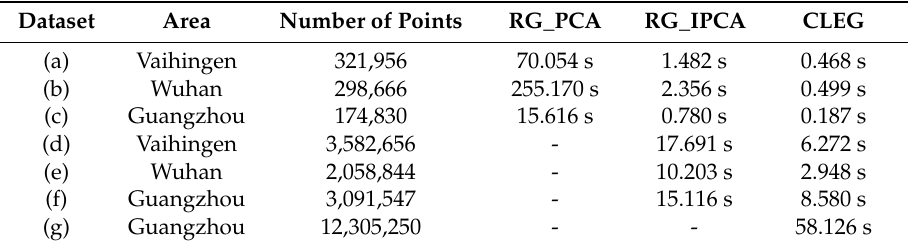
Table 7. Computation time in the comparison test.